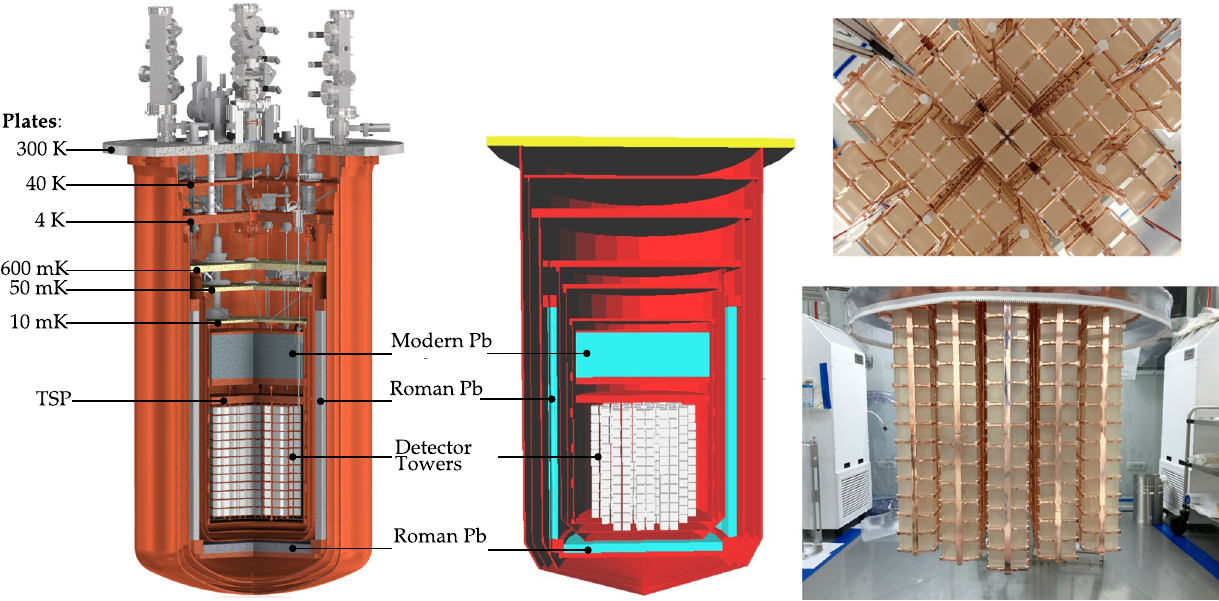
Fig. 2 Left 3-dimensional view of the CUORE apparatus. Center The CUORE setup as implemented in the Monte Carlo simulation. Cold lead shields are cyan -colored. Right Pictures of the CUORE 19-tower array seen from the bottom and from the side, courtesy of Y. Suvorov